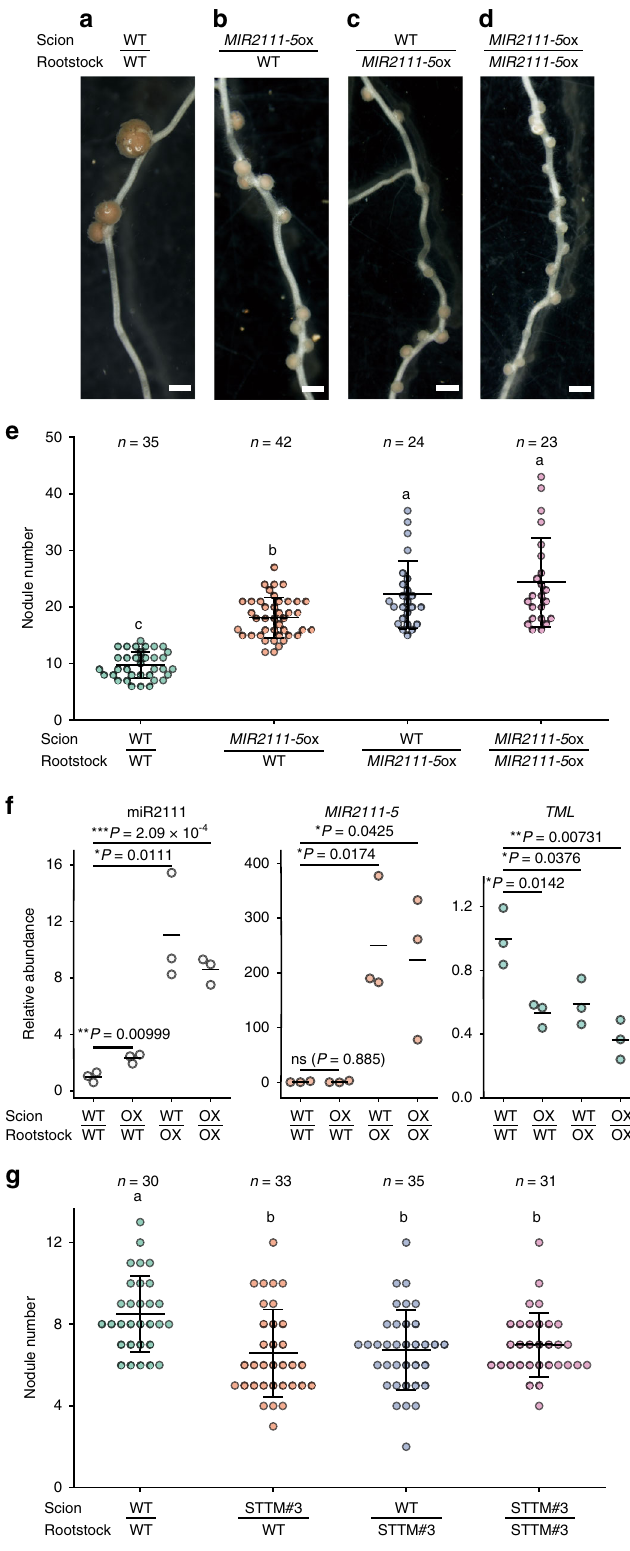
loci for miR2111 genes in the L. japonicus genome (Fig. 1 and Supplementary Fig. 1a), as for other miRNA gene families in plants 33 , a single mir2111-5 mutation decreased miR2111 levels in leaves and roots to less than half of WT (Fig. 5b). In addition, the MIR2111-5 deletions resulted in the signi fi cant inhibition of